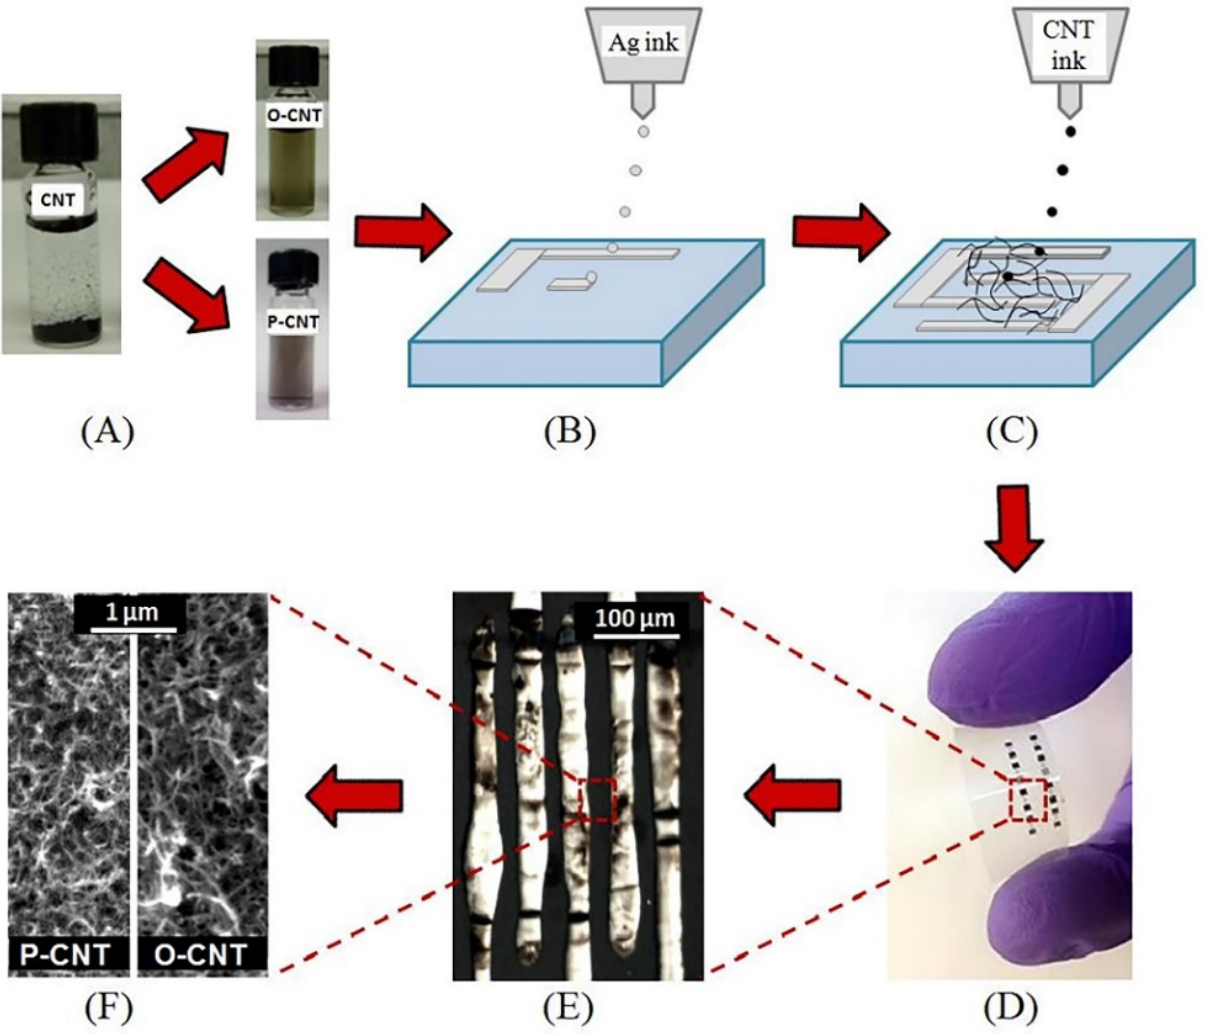
Figure 2. Fully printed and flexible CNT-based gas sensor: ( A ) CNTs functionalization with carboxylic acid (O-CNTs) and PEDOT:PSS (P-CNTs); ( B ) printing of Ag electrodes; ( C ) printing of CNT; ( D ) photograph of the sensor on flexible substrate; ( E ) optical microscope image showing the printed silver interdigitated electrodes, and ( F ) SEM image showing the printed CNTs. Reproduced from ref. [55]. Copyright 2016, Elsevier, Ltd.